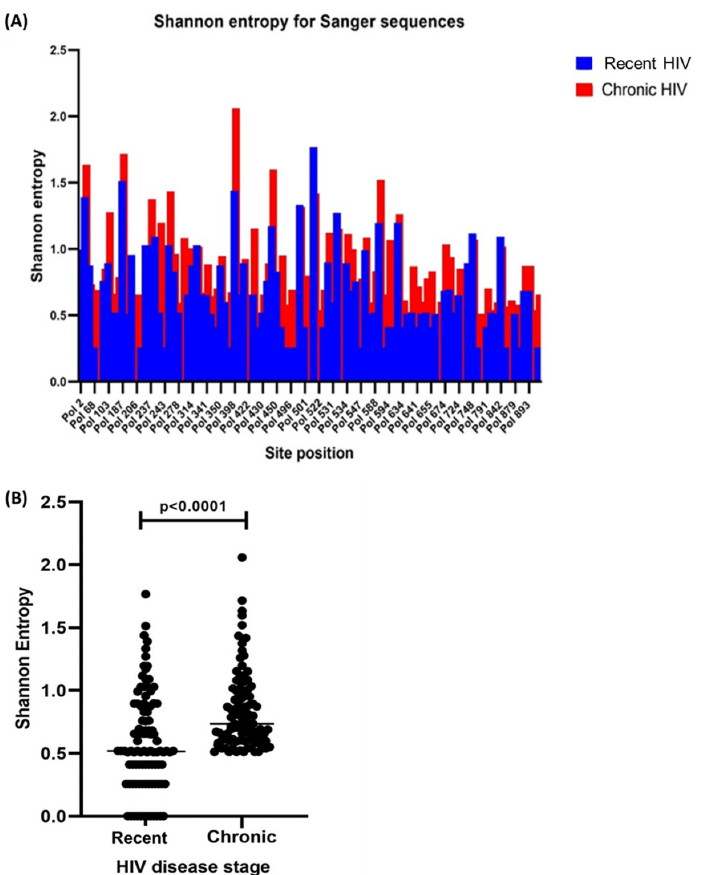
Figure 1. Shannon entropy score analysis of the complete HIV polymerase gene amino acid sequences obtained during recent and chronic HIV-1 disease stages. ( A ) Higher diversity (entropy) was observed during chronic HIV-1 infection with site-by-site entropy analysis. ( B ) A scatterplot indicating a significant difference in the median entropy scores between the two stages of infection. Graphs were plotted using GraphPad Prism. HIV = Human immunodeficiency virus.